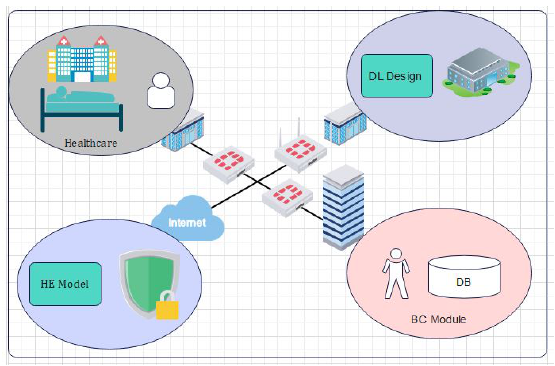
Figure 6. Flowchart for our Blockchain-based IoT